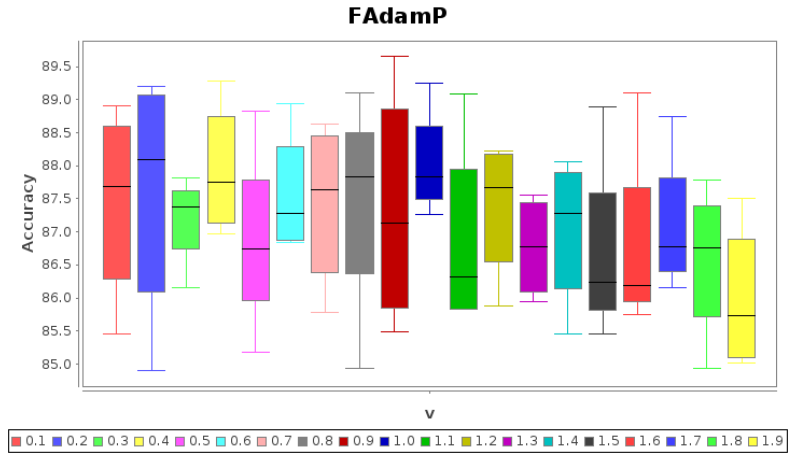
Figure 10. Experiment 2.2: FAdamP cross-folding accuracies, K = 4 folds, ν ∈ [ 0.1,1.9 ]